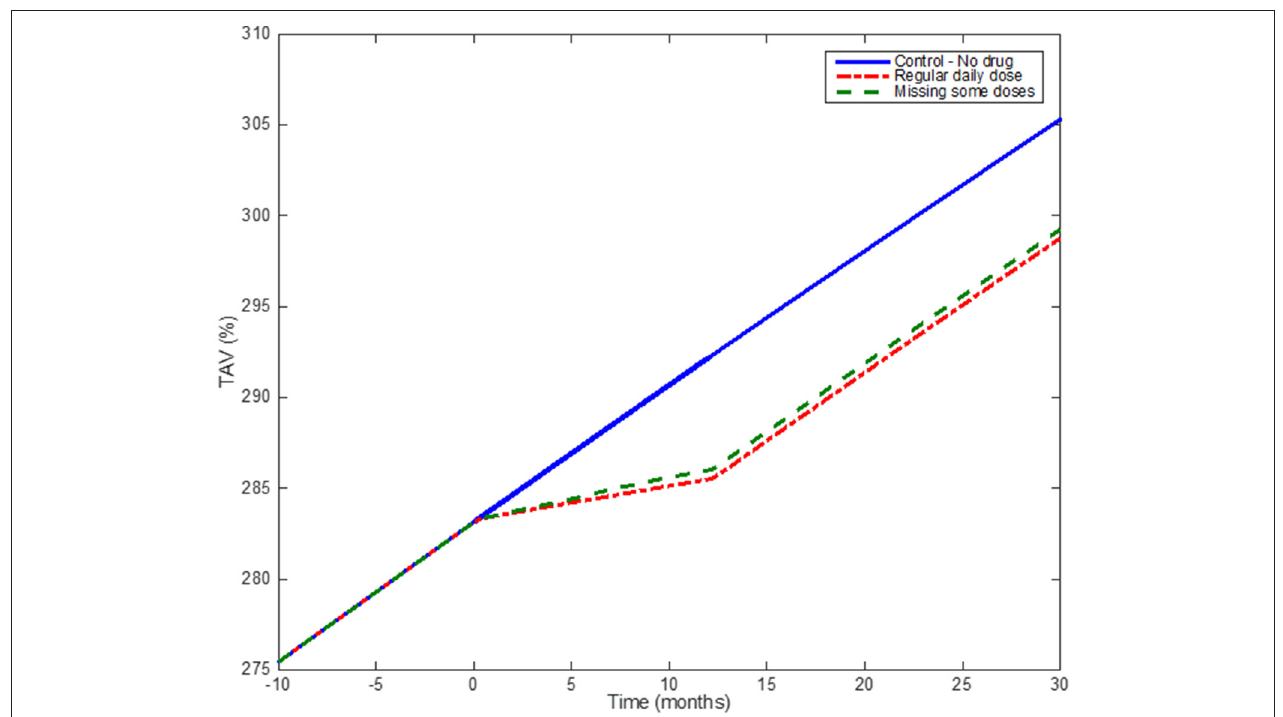
FIGURE 10 | Medication adherence: Simulation results comparing the effect of taking statins on a regular basis and missing some doses according to the output of the Markov Chain. The blue (solid) line shows the model when no drug is administered; the red dotted line shows the effect of one-year treatment with Statins (considering the patient taking the drug regularly); the green line shows the effect of a patient under the same Statin treatment but missing ∼ 10% of the total number of